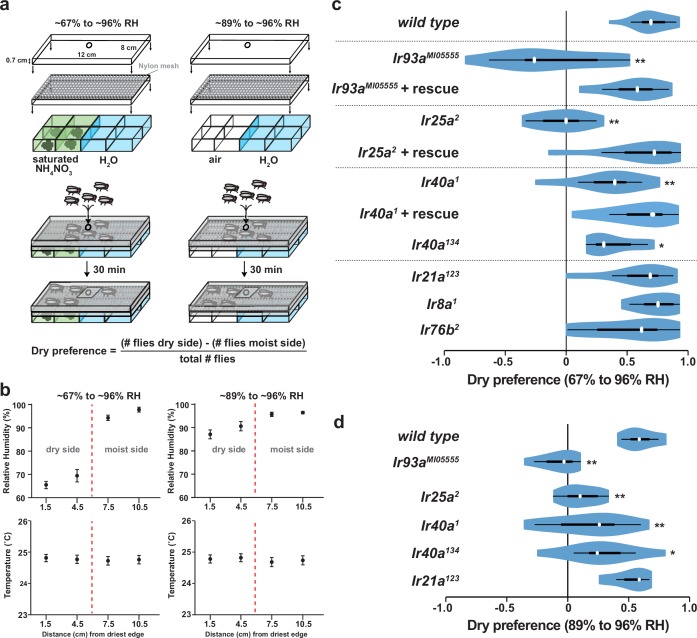
Hygrosensory behavior requires IR93a, IR25a and IR40a.(a) Schematic of the hygrosensory behavior assays. ~67% to ~96% RH gradients were generated by filling wells with either a saturated solution of ammonium nitrate in water or pure water. ~89% to ~96% RH gradients were generated by pairing empty wells with wells filled with pure water. Nylon mesh prevented fly contact with solutions. Dry preference was quantified by counting flies on either side of chamber midline. 25–35 flies were used per assay. (b) Mean ± SD of RH and temperature measured at indicated gradient positions. ~67% to ~96% RH, n = 58 gradients. ~89% to ~96% RH, n = 28. (c,d) Dry preference assessed on ~67% vs. ~96% (c) and ~89% vs. ~96% (d) gradients. Asterisks denote statistically distinct from wild type (**p<0.01; *p<0.05, Steel with control). wild type, n = 16 assays. Ir8a mutant (Ir8a1), n = 8. Ir76b mutant (Ir76b2), n = 14. Ir21a mutant (Ir21a123), n = 14. Ir25a mutant (Ir26a2), n = 11. Ir25a rescue (Ir25a2; UAS-Ir25a), n = 15. Ir40a mutant (Ir40a1), n = 15. Ir40a rescue (Ir40a1; UAS-Ir40a), n = 9. Ir40a CRISPR mutant (Ir40a134), n = 10. Ir93a mutant (Ir93aMI05555), n = 11. Ir93a rescue (Ir93aMI05555, UAS-Ir93a), n = 14. Ir40a mutant alleles and thermosensory behavior are shown in Figure 4—figure supplement 1a–b. Note that UAS-cDNA rescues were observed in the absence of Gal4 drivers, reflecting Gal4-independent expression of UAS transgenes (Figure 4—figure supplement 1c–d).